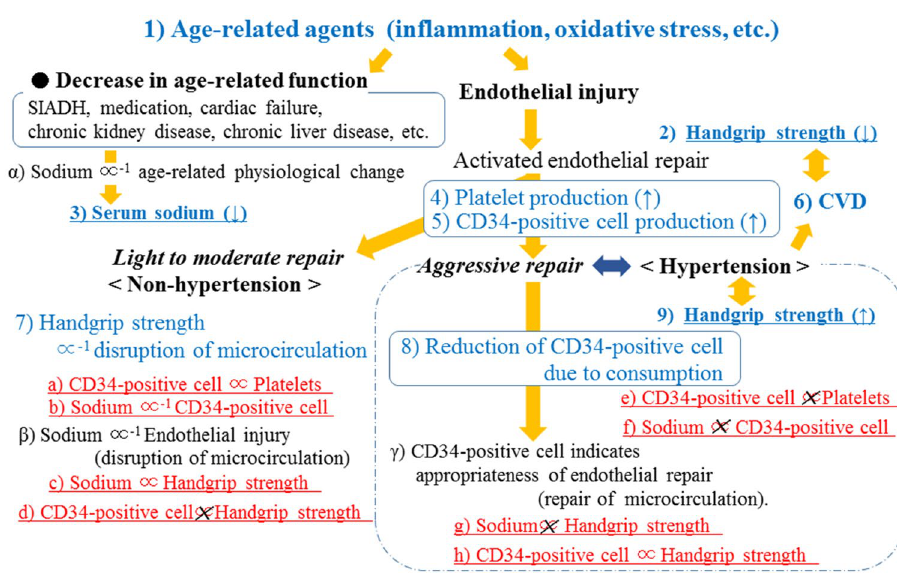
Figure 2. Possible mechanism underlying the association between serum sodium level and handgrip